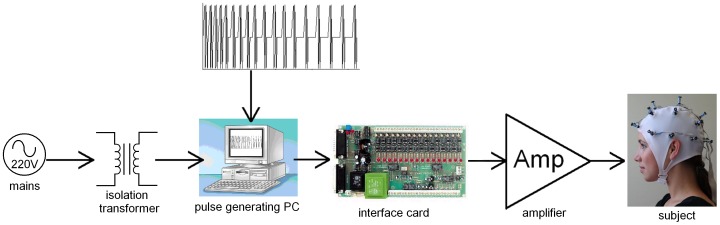
Schematic overview of the hardware.The interface card translates digital values into voltages. The amplifier in turn increases power to generate pulsed magnetic fields in nineteen small electromagnets radially attached to the head cap. Photo by S. Martens, consent to publication was obtained from the subject.